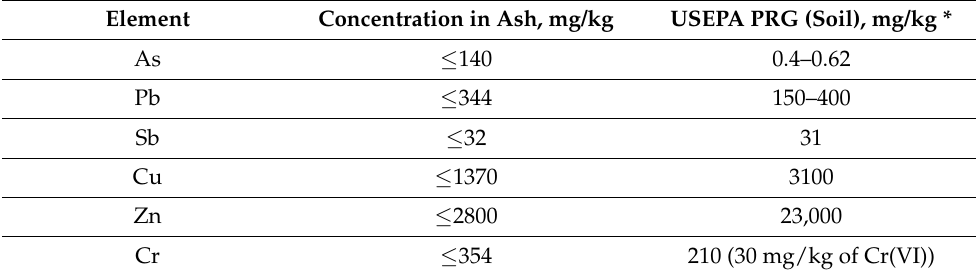
Table 7. Maximum concentrations of As, Pb, Sb, Cu, Zn, and Cr in ash from burnt areas of southern California after wildfires in 2007 and 2009 and USEPA preliminary remediation goals. Data from [83,84]. Element Concentration in Ash, mg/kg USEPA PRG (Soil), mg/kg * As ≤ 140 0.4–0.62 Pb ≤